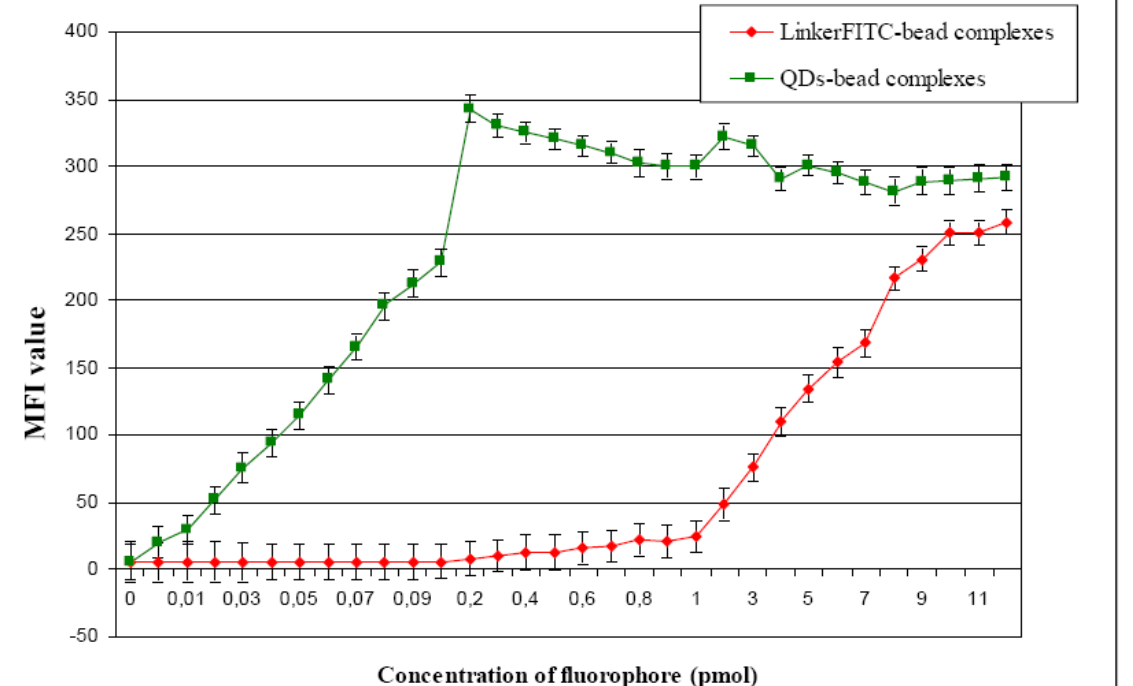
Figure 9. Fluorescent intensity of QD655-bead complexes versus the fluorescent intensity of LinkerFITC-bead complexes measured as MFI values by flow cytometry. X-axis: Concentration of QD655 and LinkerFITC in pmol bound to Dynabeads (5 µL beads, 10 mg/mL, per reaction). Y-axis: Median MFI value of each